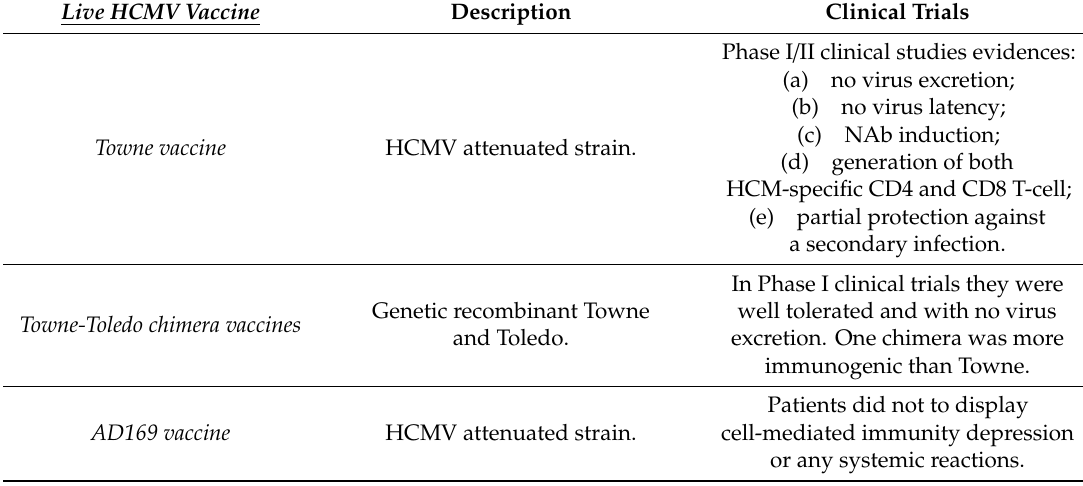
Table 2. HCMV Vaccines. NAb, Neutralizing Antibody; HELF, human embryonic lung fibroblasts; PC, pentameric complex; VLPs, virus like